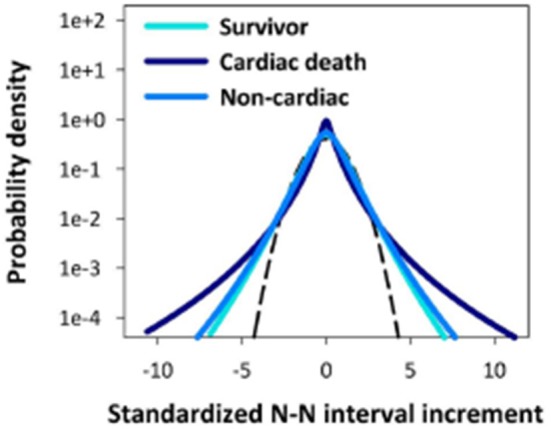
The HRV distributions are indicated schematically from 24 h RR interval time series for a group having suffered atrial myocardial infarcation. The patients are separated into those that suffer cardiac death, another with non-cariac death and third consisting of survivors (Adapted from Hayano et al., 2011).